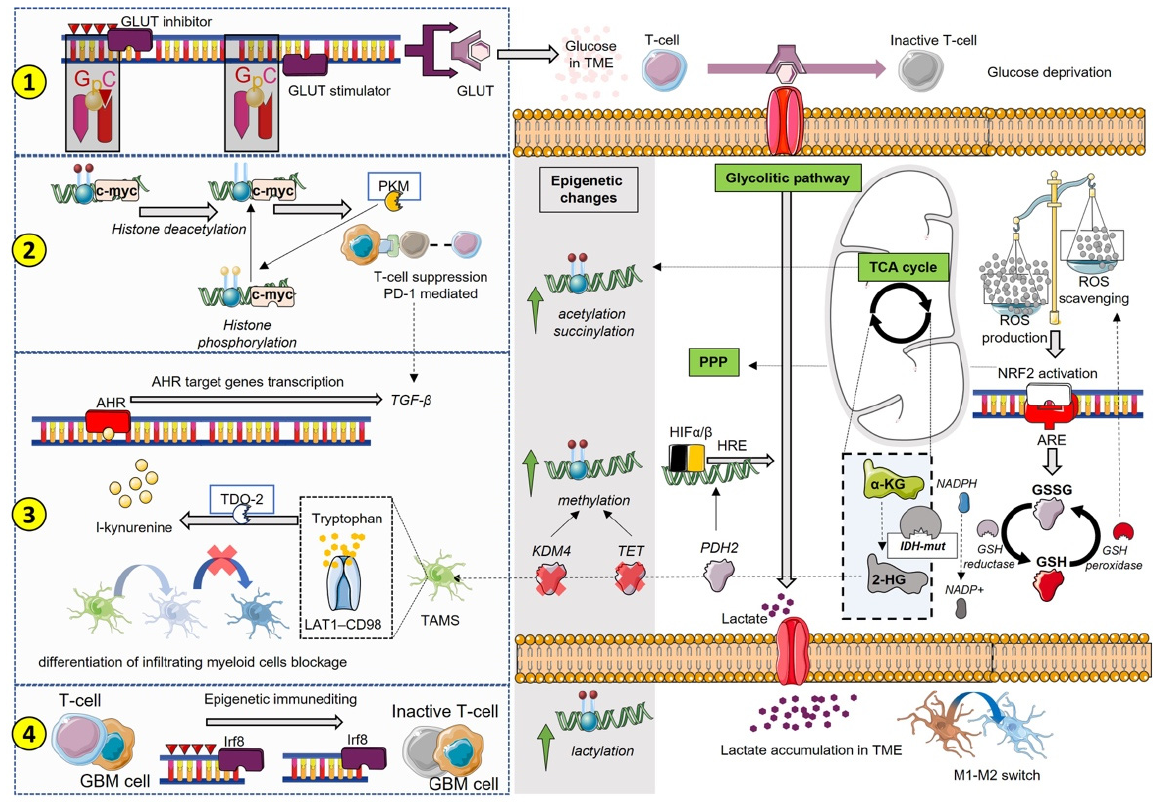
Figure 2. Several paths are involved in metabolism and epigenetics’ interplay for immunosuppres- sion. We summarized four different ways that should be recognized as interconnected rather than separate from each other. Starting from ( 1 ), the CpG islands control the expression of enzymes and factors involved in several metabolic pathways; therefore, the state of hypomethylation and hypermethylation can enhance or reduce specific metabolic pathways. For instance, methylation of GLUT inhibitors determines an increase in glucose intake, depleting the TME, where myeloid cells will not be able to perform their functions. TCA break determines an increase in lactate and a TME acidification that, besides increasing the processes of lactylation, determines mechanisms of immunosuppression including reshaping macrophages’ phenotype. ( 2 ) shows the direct involvement of epigenetic-mediated c-myc gene expression in association with PKM production and PD-1/PD-L1 immunosuppression mechanisms. ( 3 ) describes the contribution of tryptophan metabolism in 2-HG- induced TAMs, which results in the activation of AHR signaling with the production of interleukins and immunosuppressive cytokines, such as TGF- β . The production of 2-HG determines methylation changes linked to the blockade of TET and KDM4, as well as to the modulation of HIF mediated by the lack of PHD activity. ( 4 ) illustrates the effects of immune and tumor cells’ interplay inducing the so-called epigenetic immunoediting that re-educates and hijacks the transcriptional programs of the tumor towards an immunosuppressive phenotype. In this broad scenario, the alterations of the mitochondrial respiration chain must be taken into account. ROS production activates the response of genes to oxidative stress, which includes NRF2 signaling with the expression of genes and factors involved in metabolic reprogramming and immunosuppression. Among these, the production of GSH certainly plays an important role in detoxification processes that may be hindered by NADPH consumption for IDH-mut activity. Functional depletion of GSH has also an impact on antigen presentation and T cell